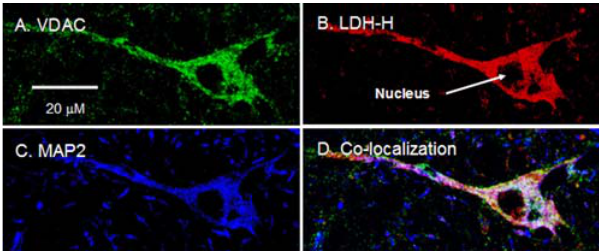
Figure 6. Immunohistochemical images of rat brain cross- sections demonstrating mitochondrial LDH-H in hippocampal neurons. Superposition of signals from probes for VDAC (A, green), LDH-H (B, red) and MAP2 (C, blue) showed extensive colocalization throughout the neuron (D, yellow/white). Scale bar=20 m m.